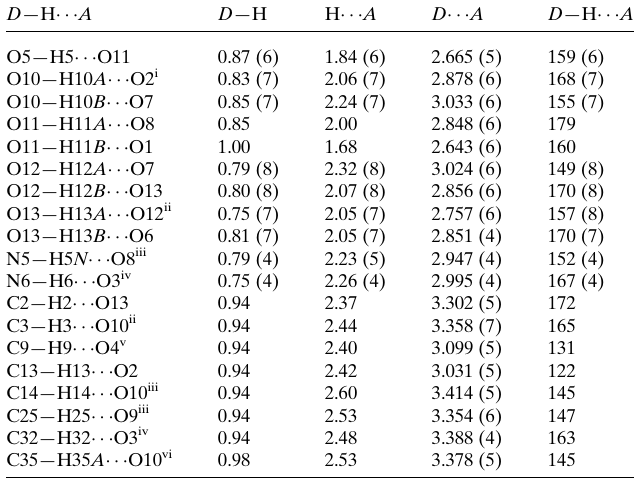
Table 1 Hydrogen-bond geometry (A˚ , (cid:3)